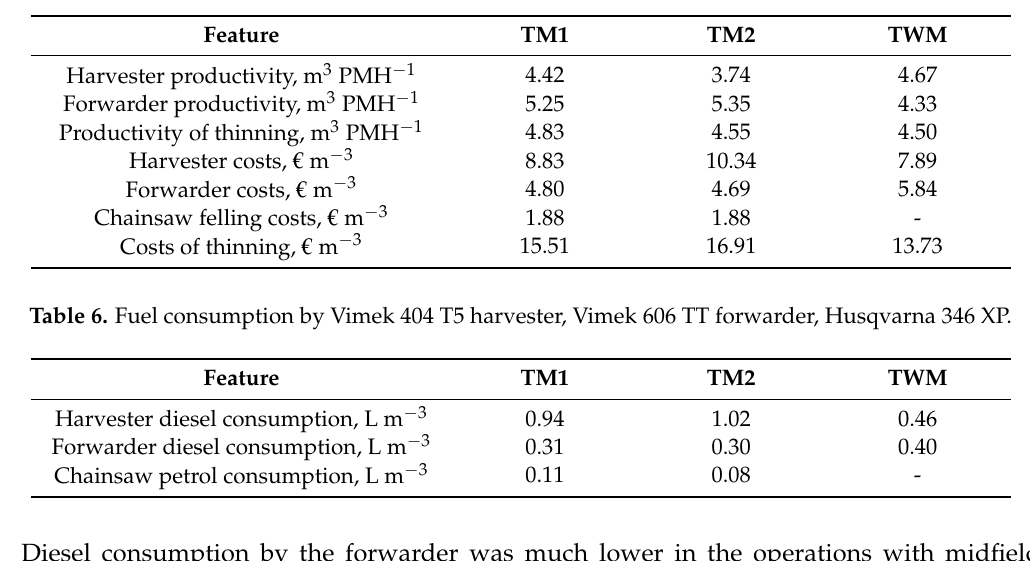
Table 5. Productivity and cost of thinning operations.